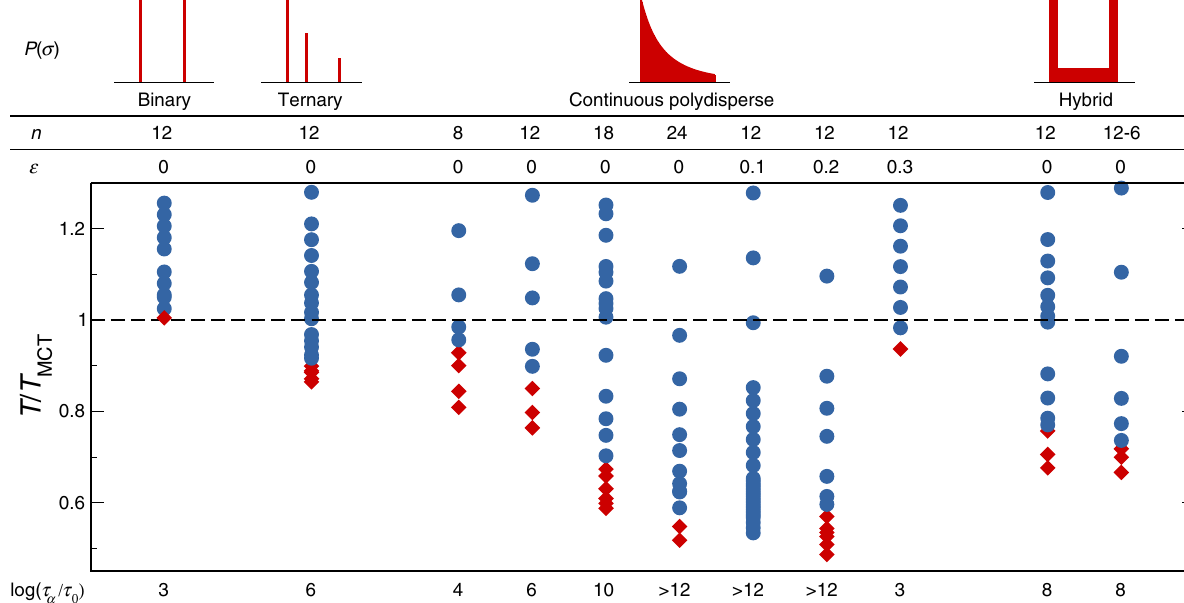
< 1 , which conventional MCT